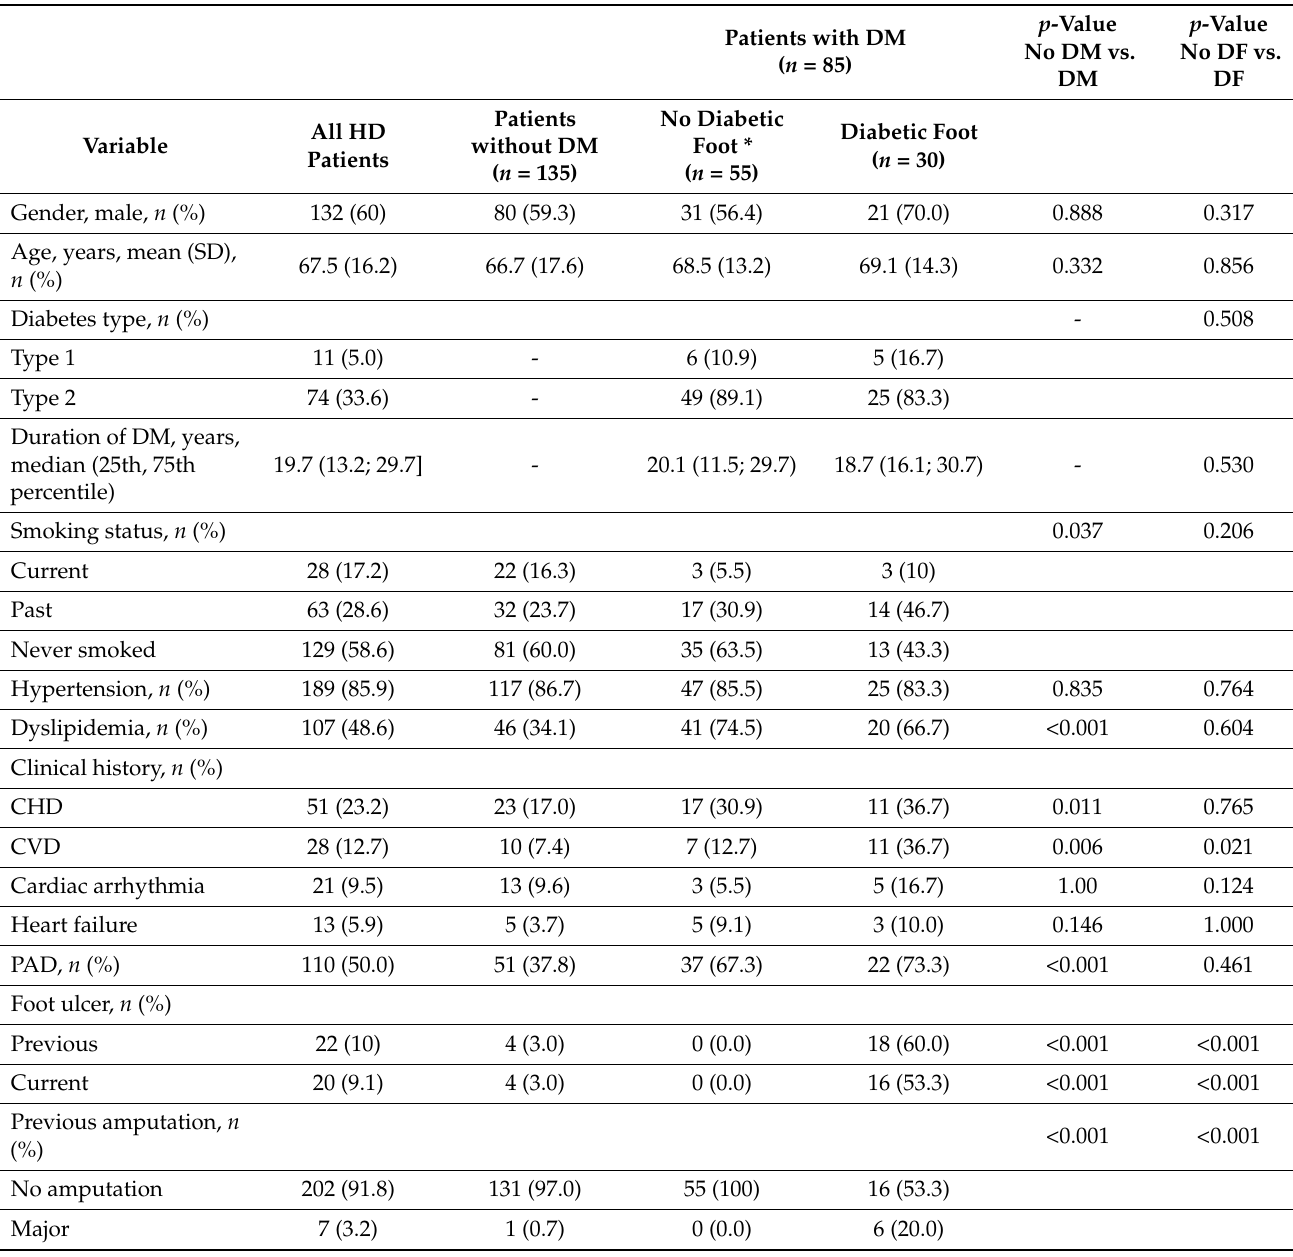
Table 1. Baseline demographic and clinical characteristics of the study